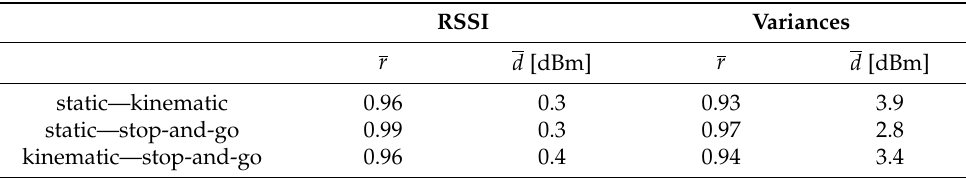
Table 5. Mean correlation coefficients and variances for the comparison of the different fingerprint